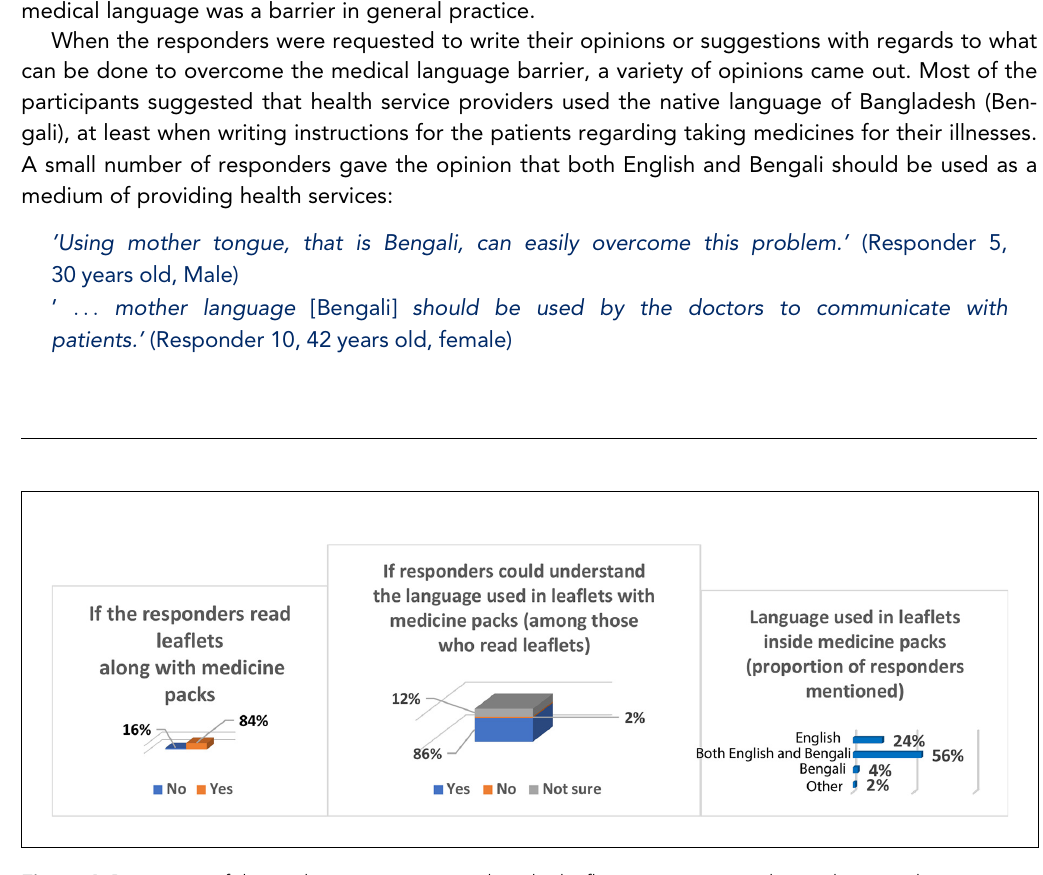
Figure 4. Perception of the study participants regarding the leaflets accompanying the medicine